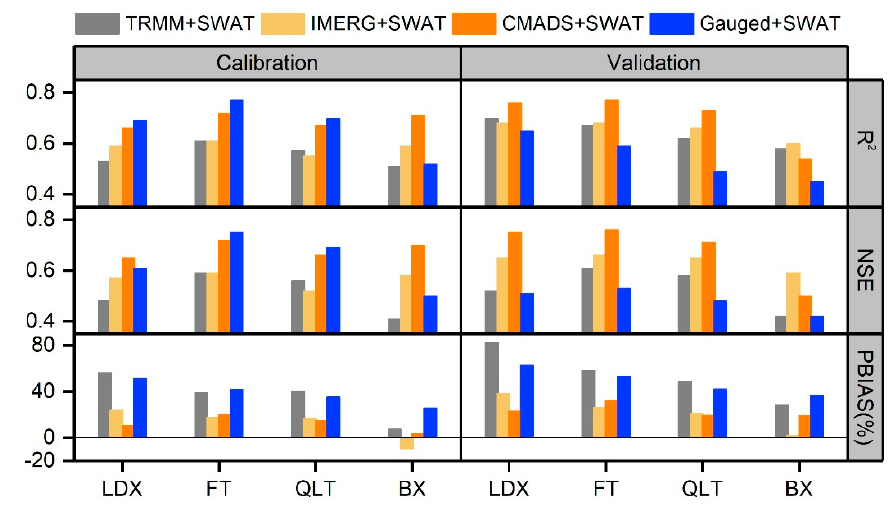
Figure 4. The Performance metrics (Coefficient of Determination (R 2 ), Nash-Sutcliffe Efficiency (NSE ) , and PBIAS) of the four modes of daily streamflow simulations.